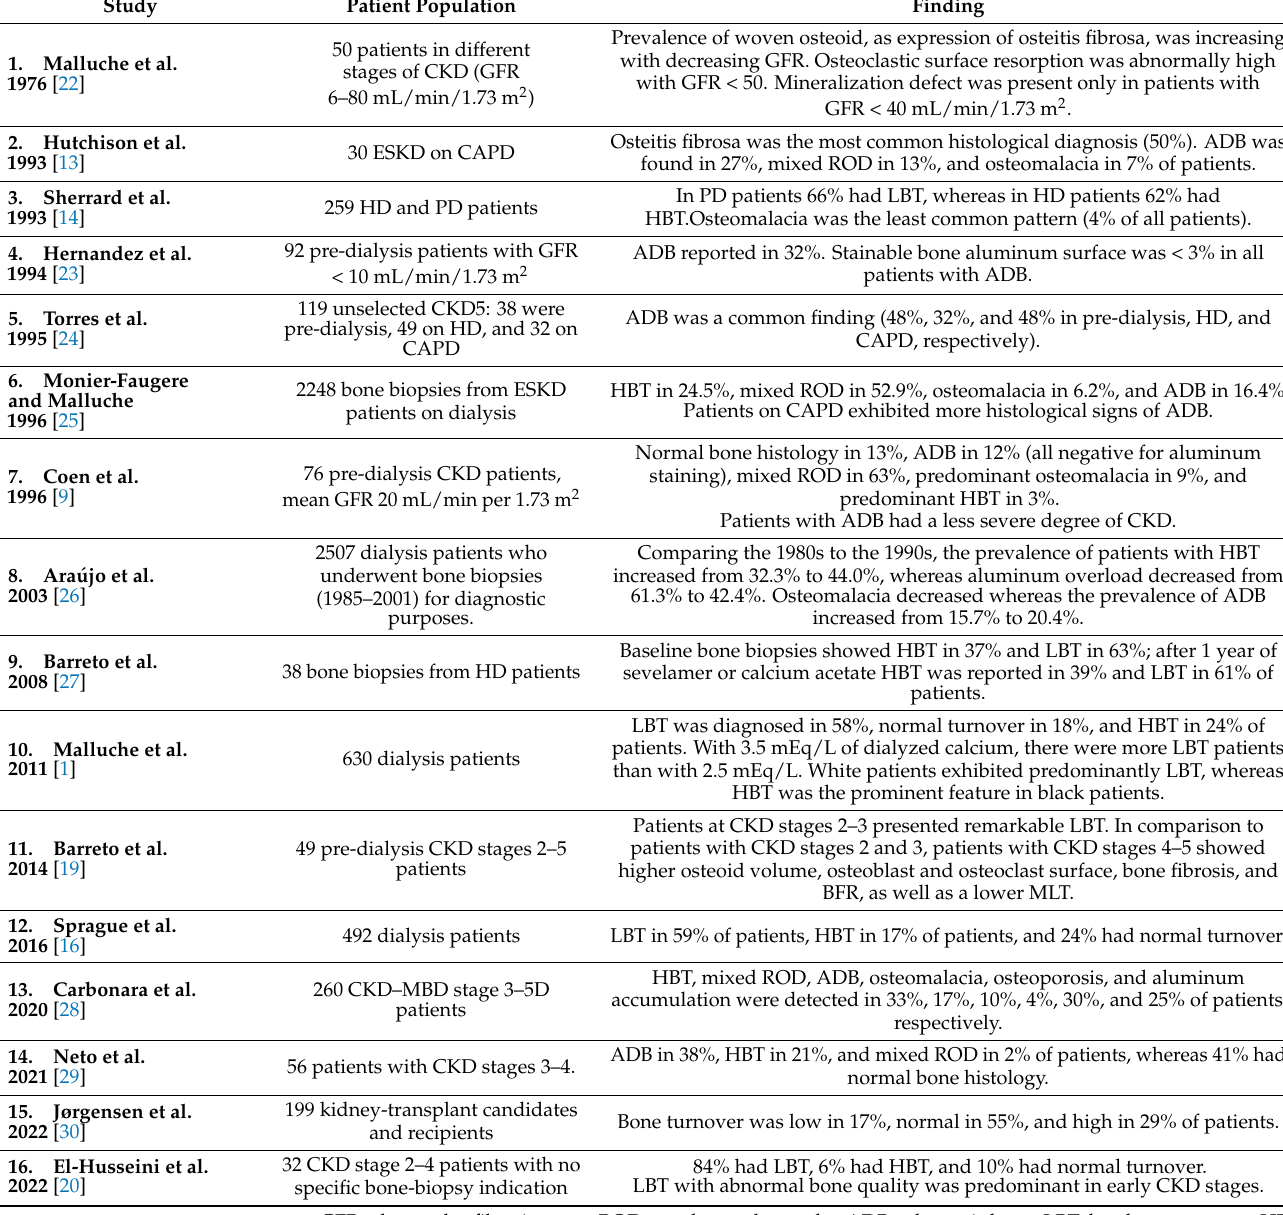
Table 1. Summary of the main bone histomorphometric studies in patients with